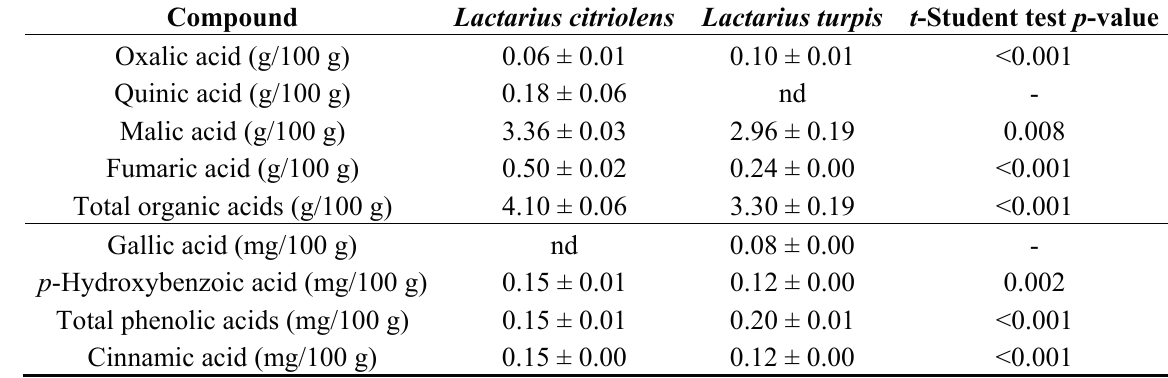
Table 2. Organic acids and phenolic compounds of the fruiting bodies expressed in dry weight basis (mean ±